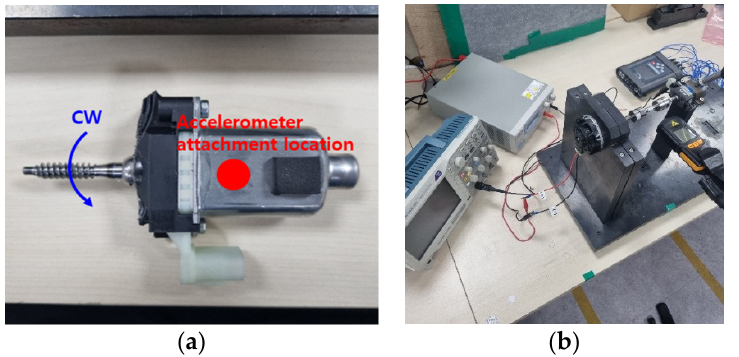
Figure 4. Experimental environment for back EMF measurement: ( a ) Vehicle window brushed DC motor without housing; ( b ) connecting the drive motor and the test motor and installing the measuring